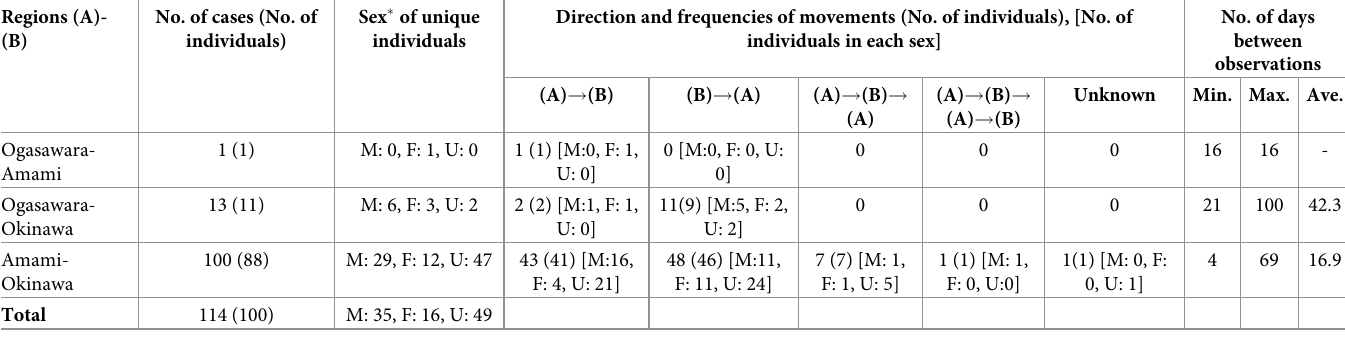
Table 5. Within-season movements of whales between Ogasawara, Amami and Okinawa. Regions (A)- No. of cases (No. of (B) individuals)